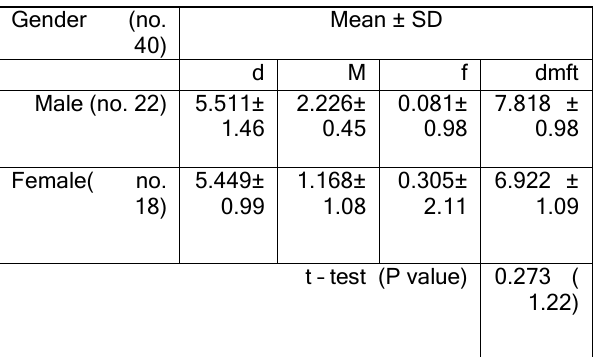
Table (5) demonstrated the dmft index of autistic children in the first